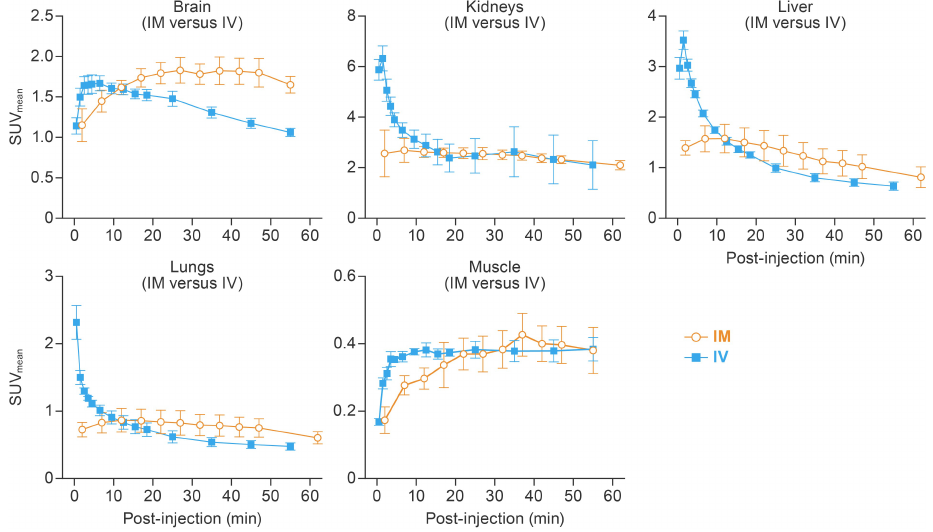
Figure 2. Temporal and spatial distribution of [ 18 F]F-FDG after IM and IV injections. Dynamic PET scans were performed 0–55 min post-injection for IM and 2–62 min for the IV route. Mean time–activity curve of the brain, lungs, liver, kidneys, and muscle are presented. Error bars represent one SD. [ 18 F]F-FDG, 2-deoxy-2-[ 18 F]fluoro-D-glucose; IV, intravenous; IM, intramuscular; SUV mean , mean standardized uptake value; PET, positron emission tomography; SD, standard